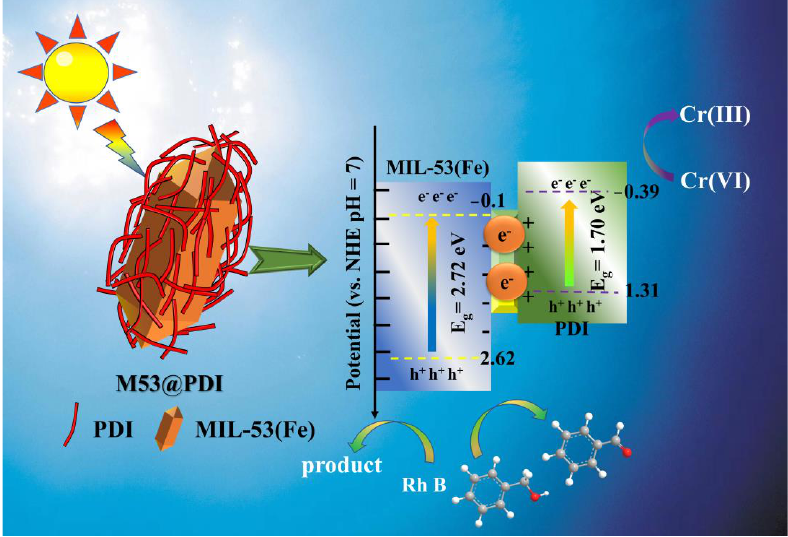
Figure 10. A possible photocatalytic mechanism over MIL-53(Fe)@PDI heterojunctions.